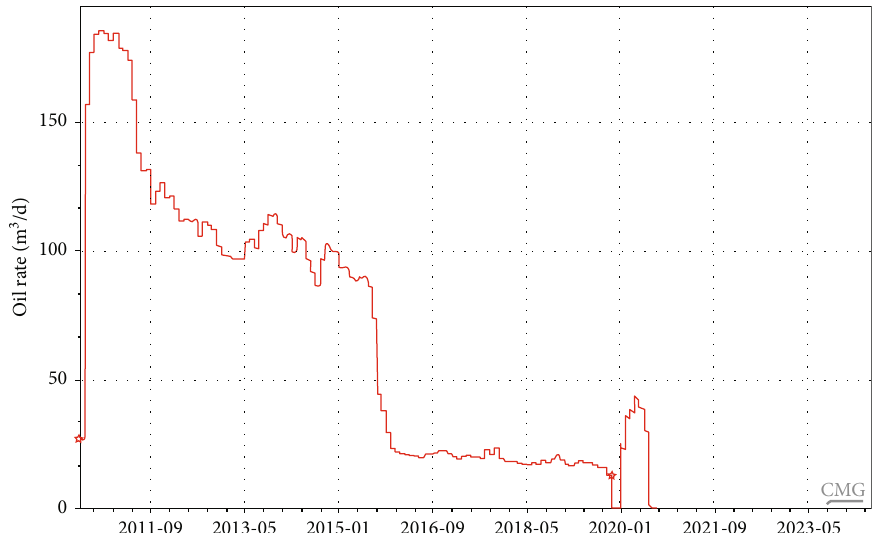
Figure 18: L110X well gas injection development increasing e ff